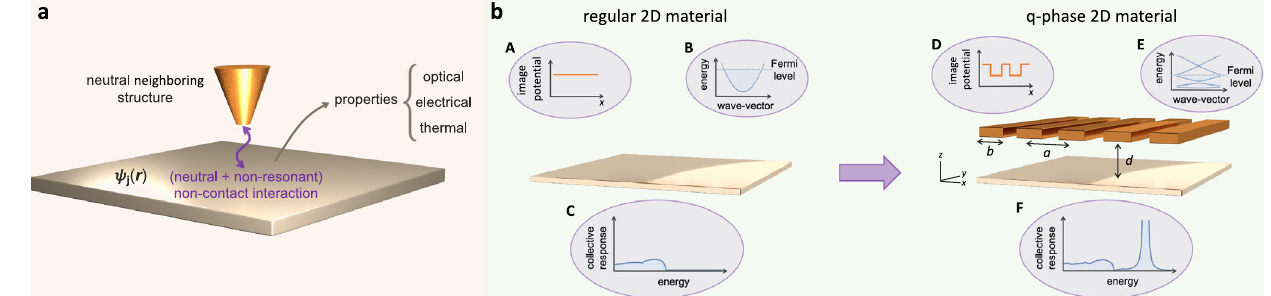
Fig. 1 | Realization of a quantum-phase (Q-phase) material. a Sketchof the non- contact interaction between a two-dimensional (2D) material and a neighbor- ing neutral structure. The image potential experienced by conduction electrons in the material imprints a Q-phase on their wave functions ψ j ( r ) that in turn changes the optical, electrical, and thermal transport properties. b Possible realization of a Q-phase material. In the absence of an additional structure, there is no image interaction (A), so conduction electrons exhibit a characteristic parabolic